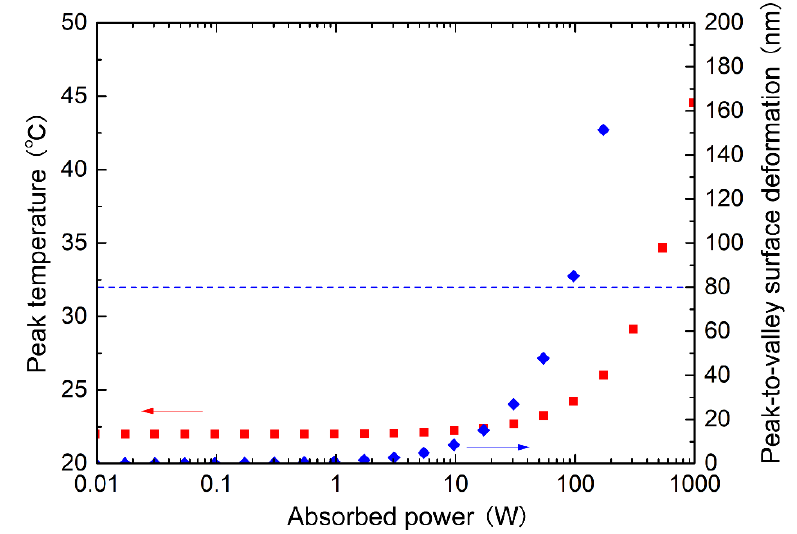
Figure 8. Calculated peak temperature (red square) and peak-to-valley surface deformation (blue diamond) for 50 × 27 × 4 cm SiC ceramic substrate. Dashed line shows the deformation limit (80 nm) of grating.